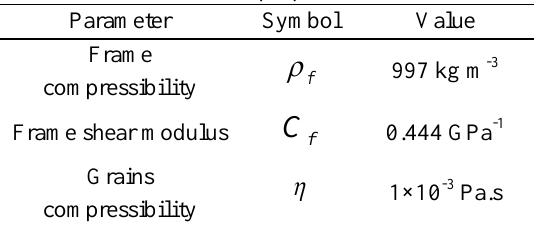
Table 2. Material properties of Water.